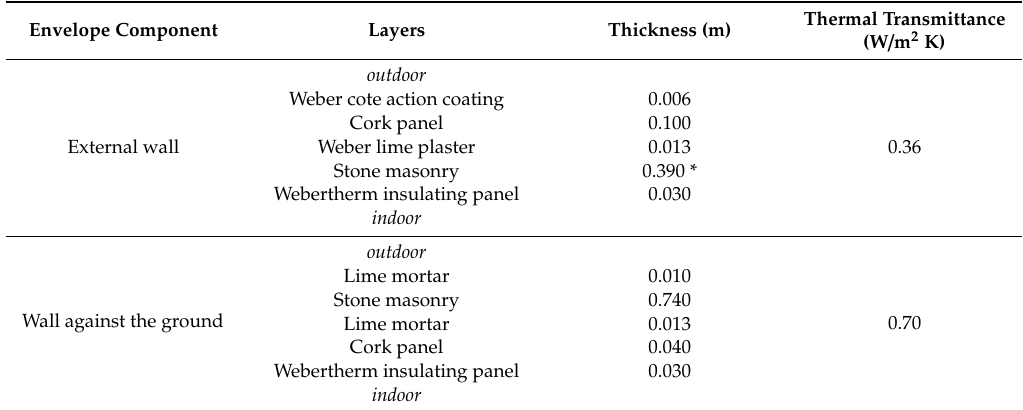
Table 2. Thermo-physical characteristics of the main opaque envelope